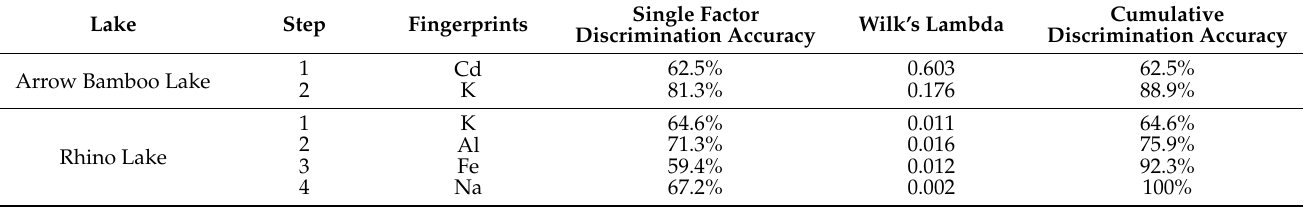
Table 2. Optimum composite fingerprint and classification accuracy at Arrow Bamboo and Rhino